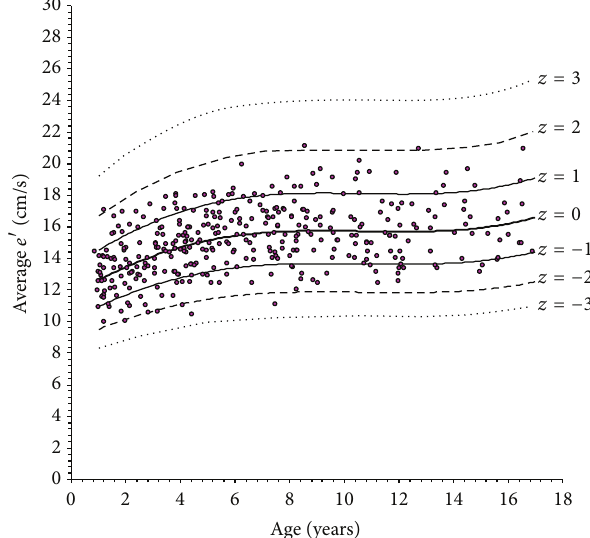
Figure 3: Scatterplot of peak early diastolic left ventricular longitu- dinal velocity ( 𝑒 󸀠 ) versus age.